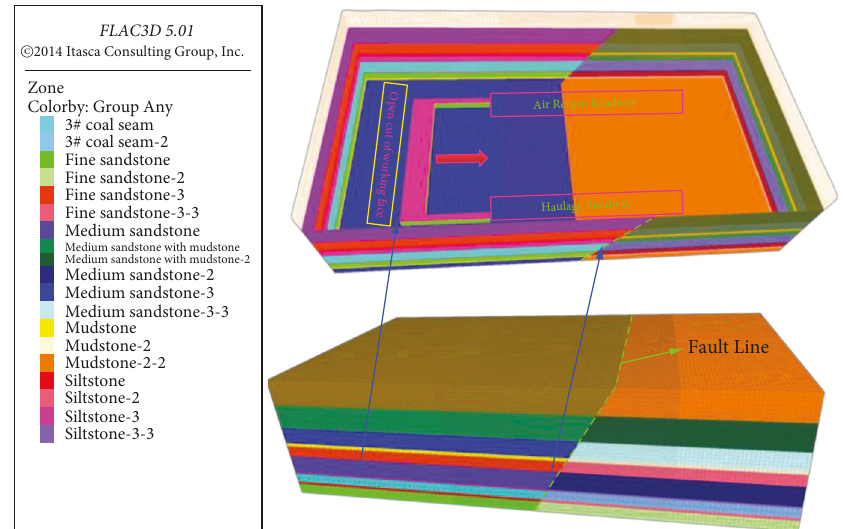
Figure 5: Relative position of FD8 fault and stope of numerical simulation experimental model.